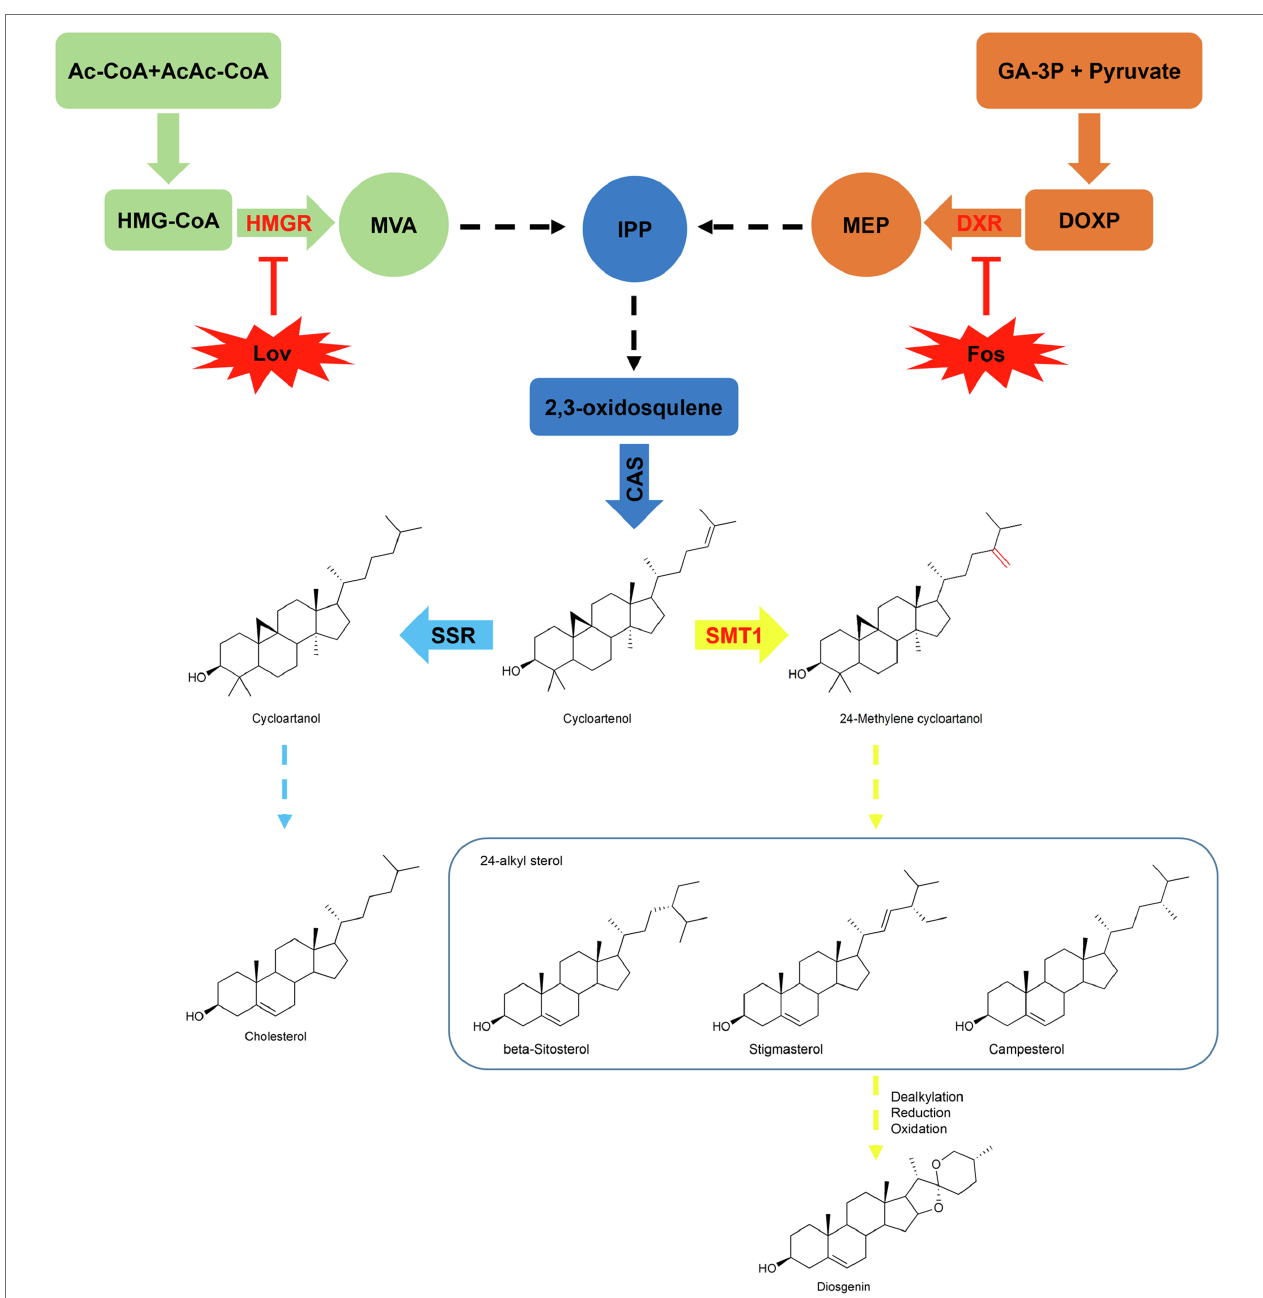
FIGURE 1 | Proposed pathway of diosgenin via 24-alkylated sterols. Cholesterol and 24-alkylated sterols are biosynthesized from a common substrate cycloartenol, which is diverted to cycloartanol by SSR (sterol side chain reductase) in the steps up to cholesterol or to 24-methylenecycloartenol by SMT1 (sterol methyltransferase type 1) in the steps toward biosynthesis of 24-alkyl sterols (e.g., stigmasterol, beta-sitosterol, and campesterol). In the upstream steps, they originate from the isoprenoid unit IPP (Isopentenyl diphosphate) via the mevalonate (MVA) or the non-mevalonate (MEP) pathway. Lovastatin (Lov) and Fosmidomycin (Fos) are the specific enzyme inhibitors